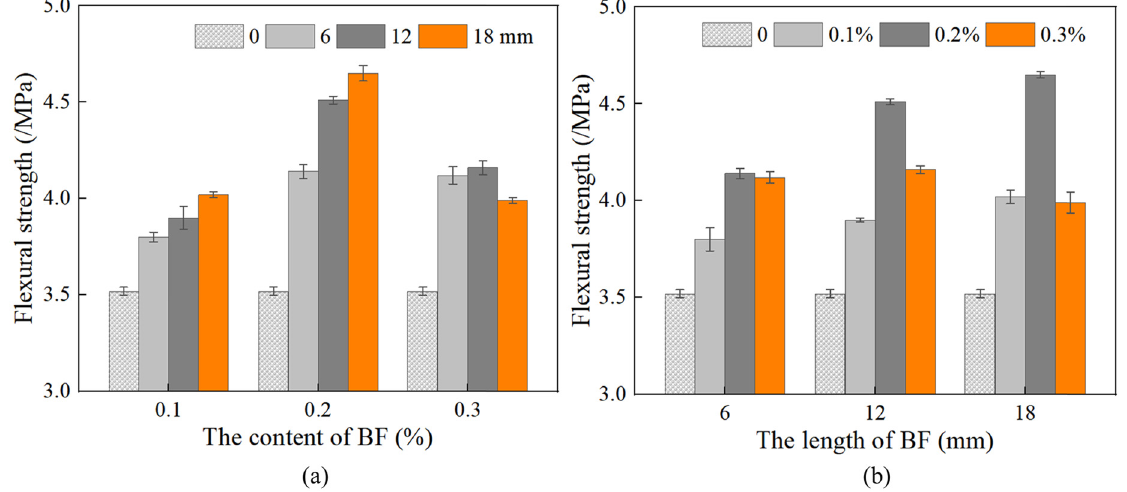
Figure 14: E ff ect of BF on the fl exural strength of RAC. ( a ) RAC with di ff erent BF contents. ( b ) RAC with di ff erent BF